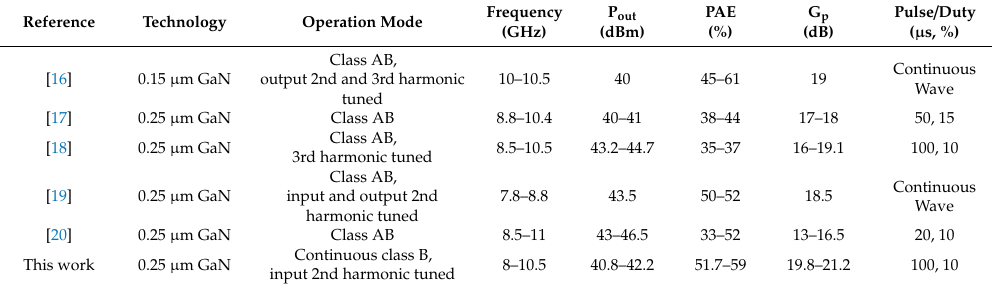
Figure 13. ( a ) Simulated and measured Pout, PAE, and gain versus frequency from 7.5 GHz to 11.5 GHz; ( b ) simulated and measured S-parameter versus frequency from 7.5 GHz to 11.5 GHz; ( c ) simulated and measured gain versus input power at 10 GHz. Table 1. Comparison with recent reported state-of-the-art X-band power amplifier (PA)